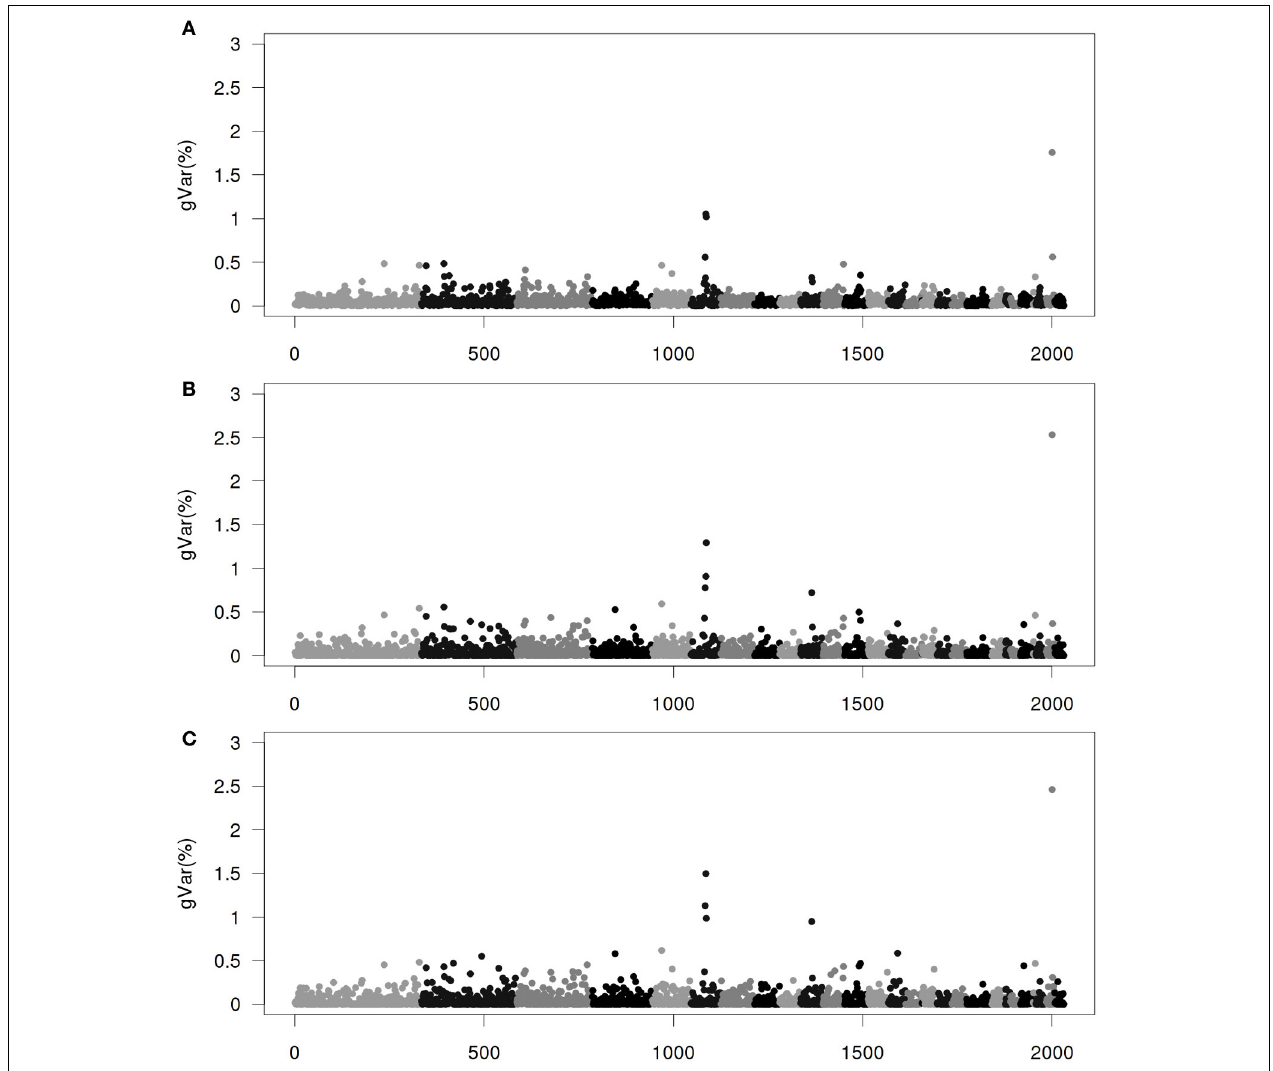
FIGURE 1 | Proportion of genetic variance of 20-SNP region under the Senarios 1 (ssGWAS1) of extended single-step genomic BLUP (ssGBLUP). (A) The first iteration (ssGWAS1/1). (B) The third iteration